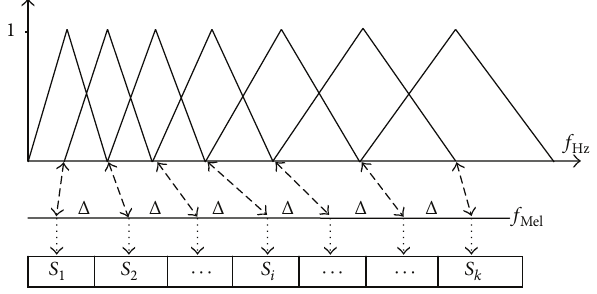
Figure 4: Principle of Mel scale filter bank.